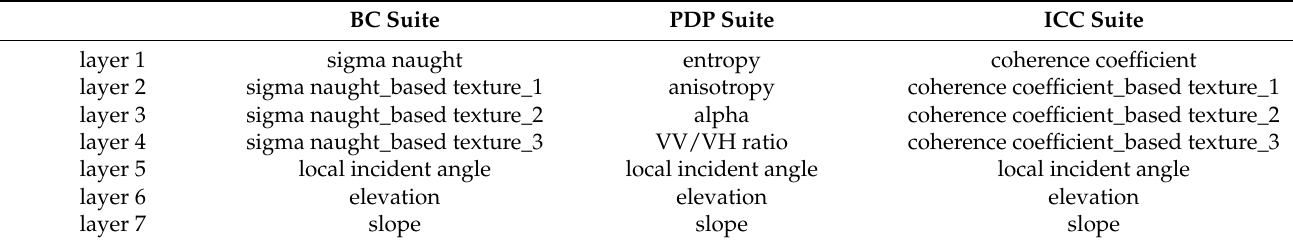
Table 2. Parameters (layers) included in each of the three data suites.